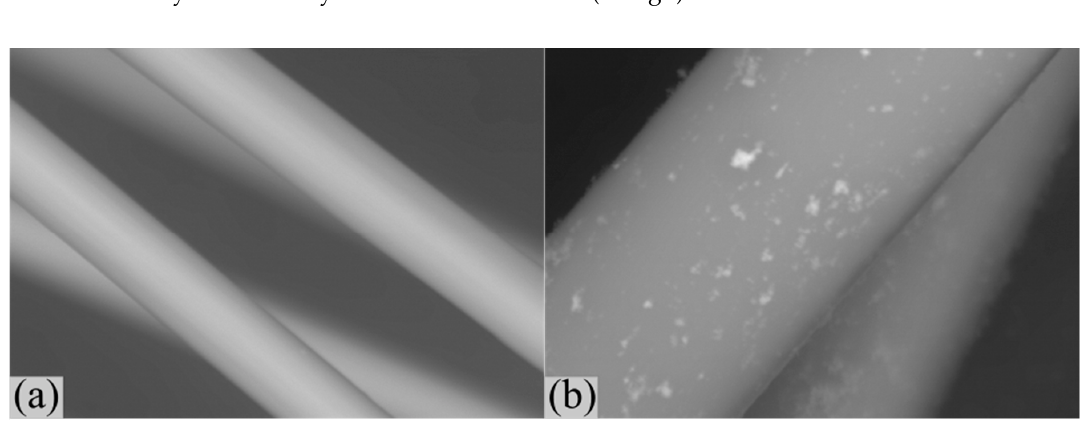
Table 2. Measured values of the remanufactured composites.